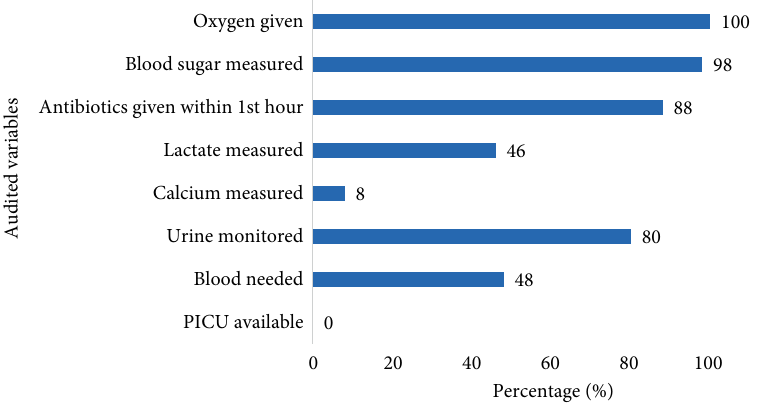
Figure 2: Audit of measured variables at 1 st hour of recognition of shock. Table 2: Audit of interventions of septic shock during 1st hour after recognition of septic shock.